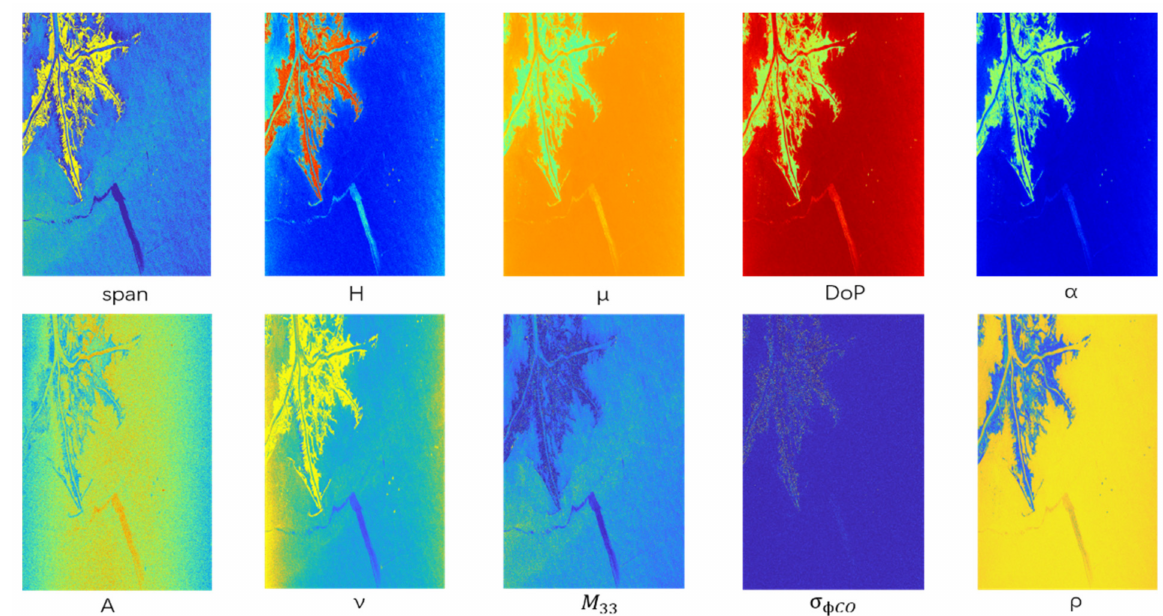
Figure 6. Presentation of ten prominent polarimetric features of image 3 by PolSARpro software and MATLAB.